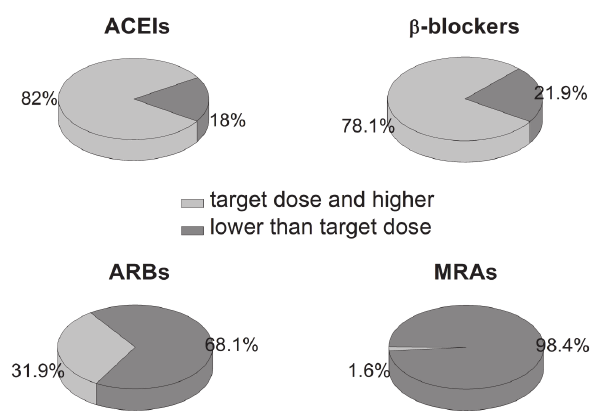
Fig. 1. Percentage of patients on target and higher than target dose of medication in each medication group (ACEIs, beta- blockers, ARBs, MRAs) at the time of the latest data collection.